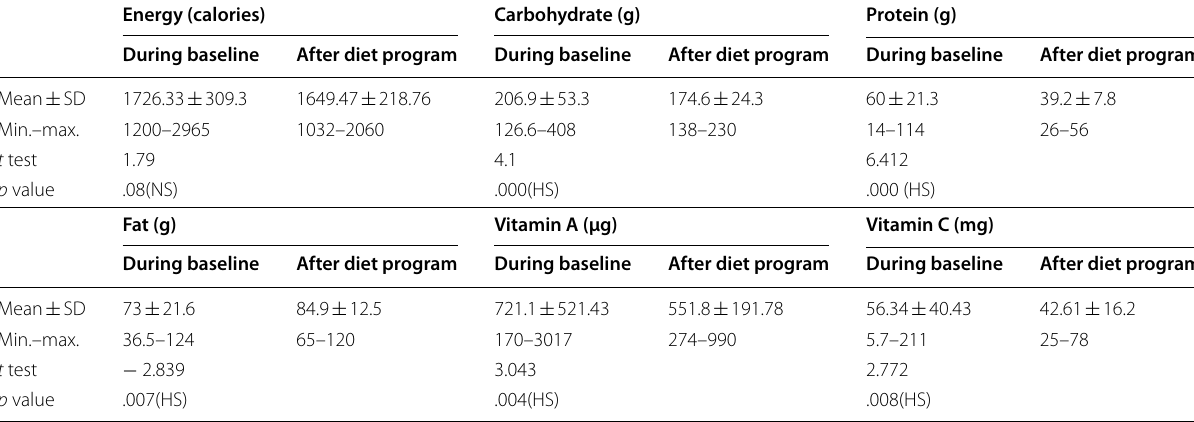
Table 3 Comparison of macronutrients and micronutrients intakes in the studied children during baseline period and after diet modification